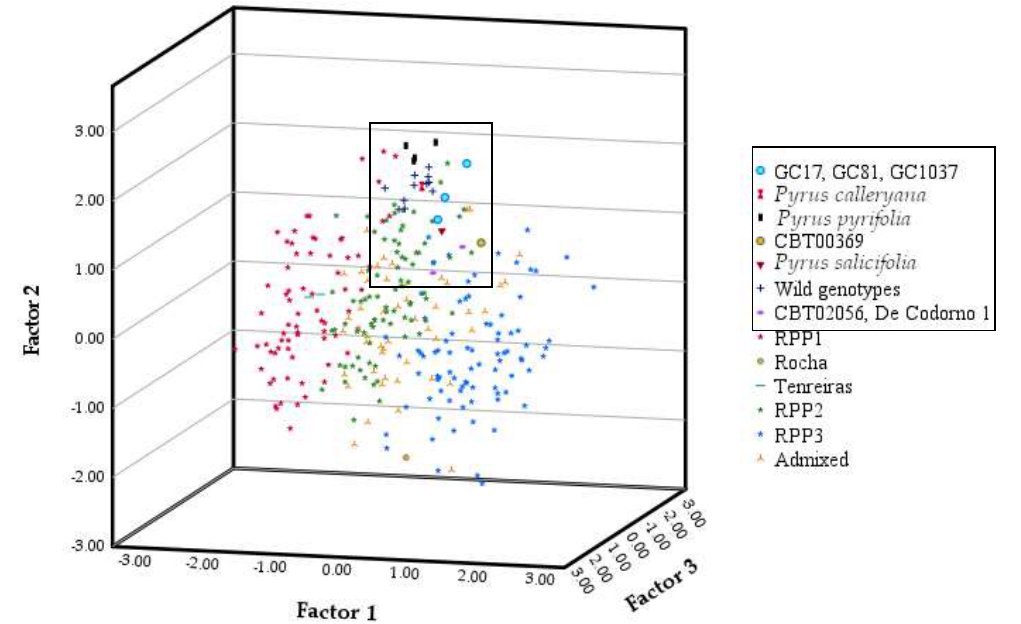
Figure 5. Three first principal components (PCs) of the PCoA for the genotypes differentiated with JC ≤ 0.13 and the RPPs using STRUCTURE for 310 pear genotypes.